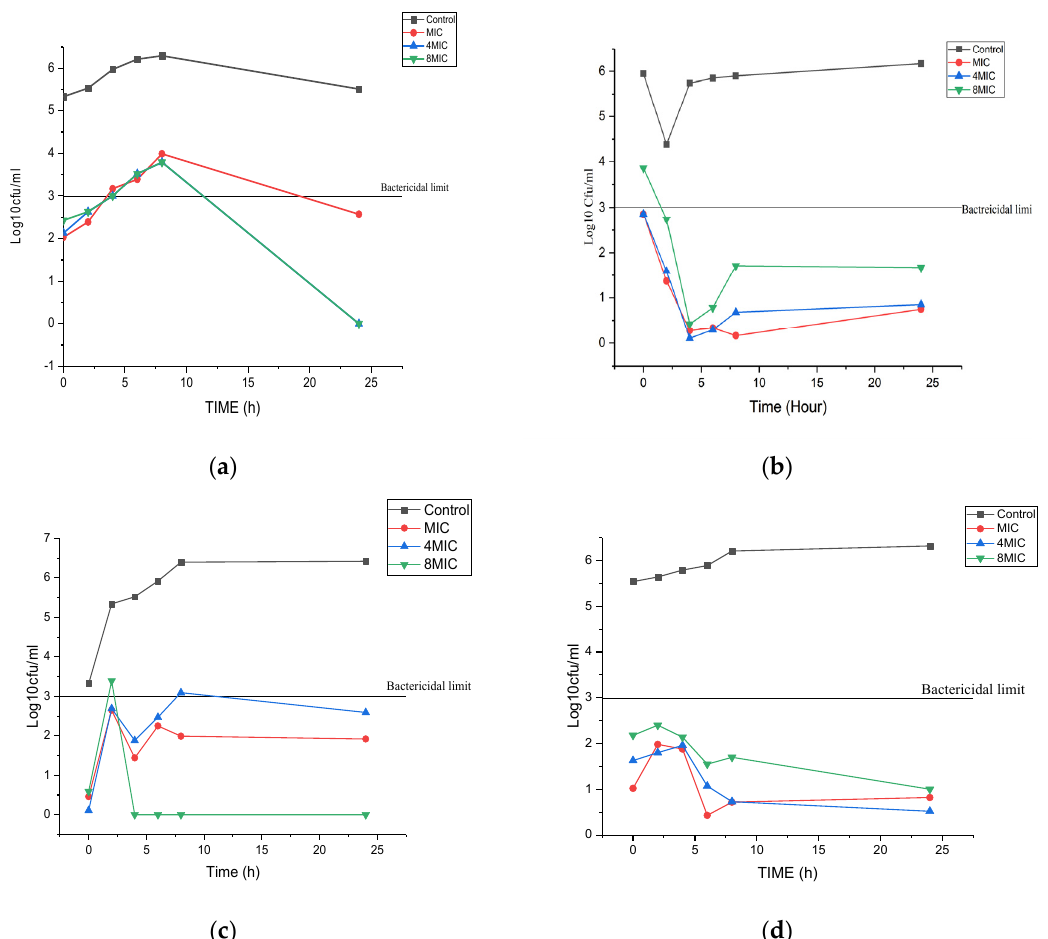
Figure 1. Time − kill curves of TCAF2 treated with different concentrations against ( a ) S. aureus (clinical isolate), ( b ) P. vulgaris (clinical isolate), ( c ) S. typhi (MTCC 733), and ( d ) MRSA 1503.